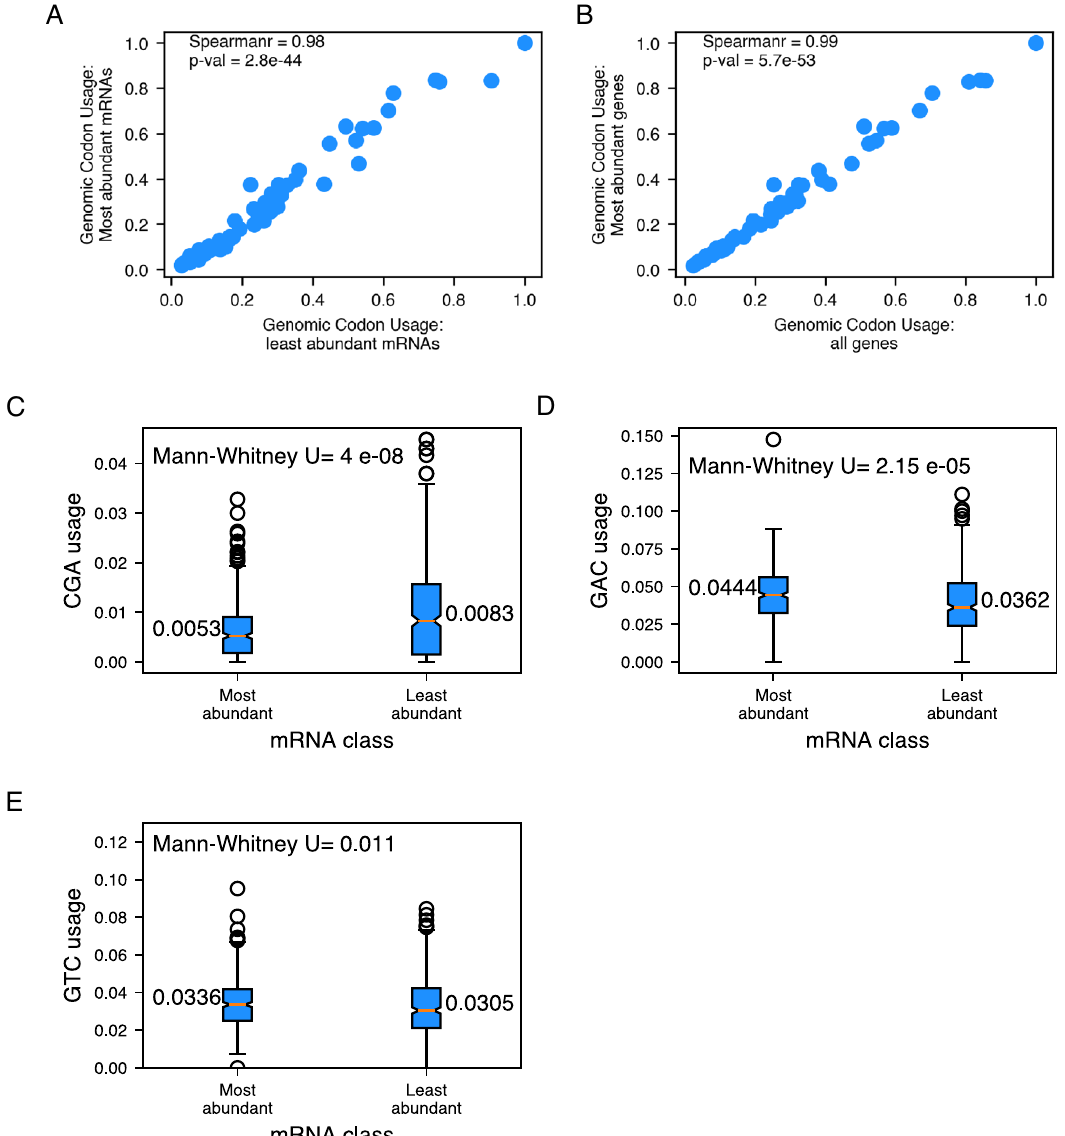
Figure 3. There are no drastic differences in the codon usage for most abundant and least abundant mRNAs in Mtb. ( A , B ) Scatterplots showing the correlation between most abundant mRNAs and least abundant mRNAs ( A ) and all mRNAs ( B ). Spearman correlation coefficient and p-values are given in the plot. ( C–E ) Comparison of usage of codons CGA ( C ), GAC ( D ), and GTC ( E ) between most abundant and least abundant mRNAs. P -value from a Mann–Whitney U test is given. Numbers on the sides of the boxes indicate the median